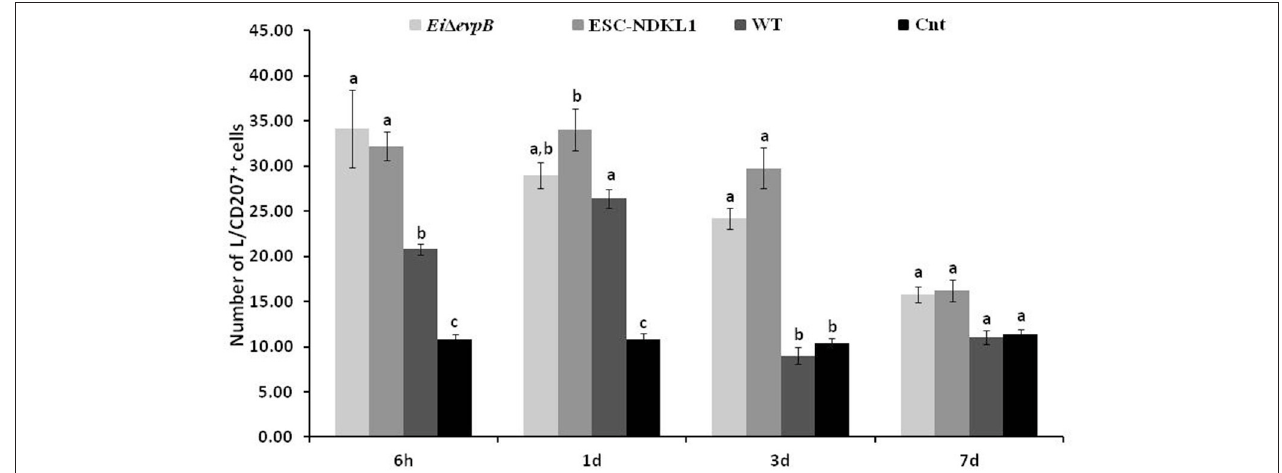
FIGURE 3 | The kinetics of L/CD207 + cells numbers in the anterior kidney of catfish challenged with E. ictaluri LAV and WT strains. The (a, b, c) letters on top of bars indicate statistical group differences in L/CD207 + cell numbers at each time point ( P < 0.05). The data represent the mean of cell numbers from five AKs ± SD.